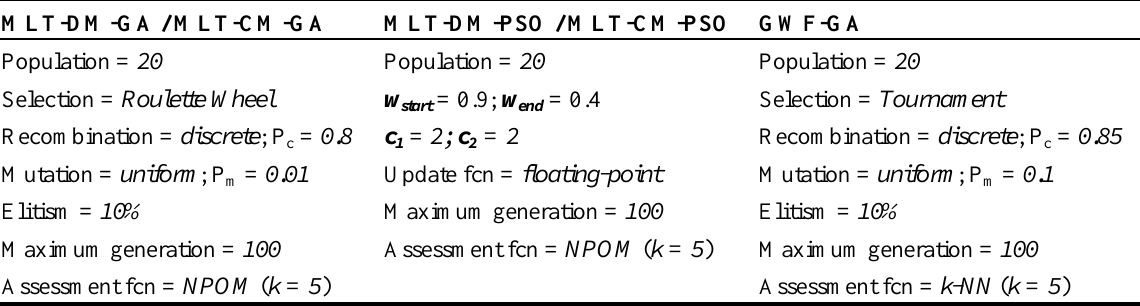
Table 4. Parameter settings of GA and PSO.